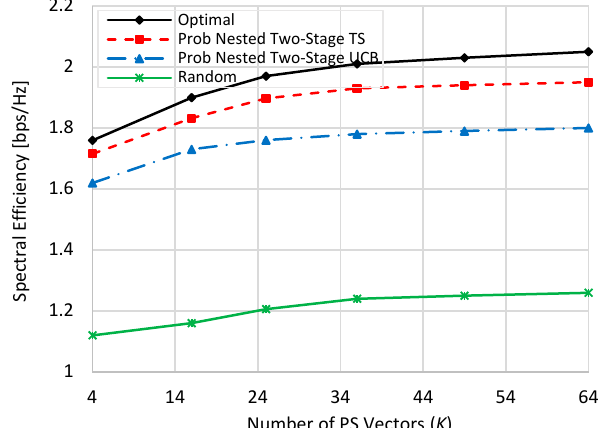
Figure 5. Spectral efficiency against the used number of PS vectors when N = 36 and M = 64 at 80% blockage.